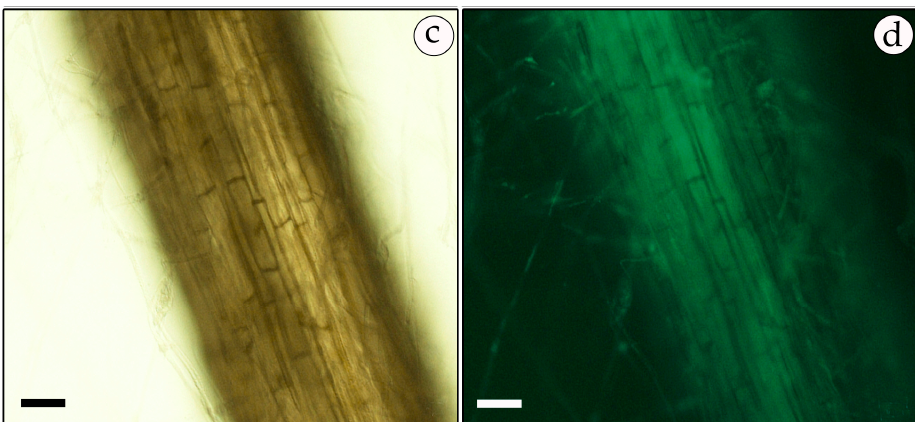
Figure 9. Expression of GFP in T. boudieri hyphae under ectomycorrhizal association with H. sessiliflorum roots. Left panels: bright field showing hyphae wrapping the roots ( a ). Right panel: GFP expression in the apoplast of the transformed hyphae under mycorrhiza marked with the white arrow ( b ). Non-transformed mycorrhized hyphae exhibit diffuse fluorescence background ( c , d ). 200X magnification. Bar = 20 μ m.